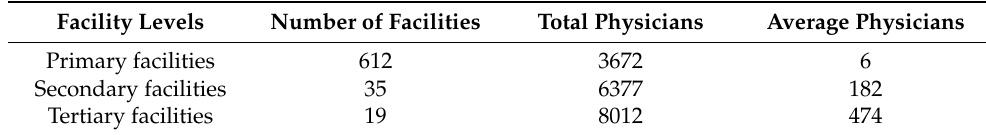
Table 1. Basic statistics of the hierarchical healthcare facilities in